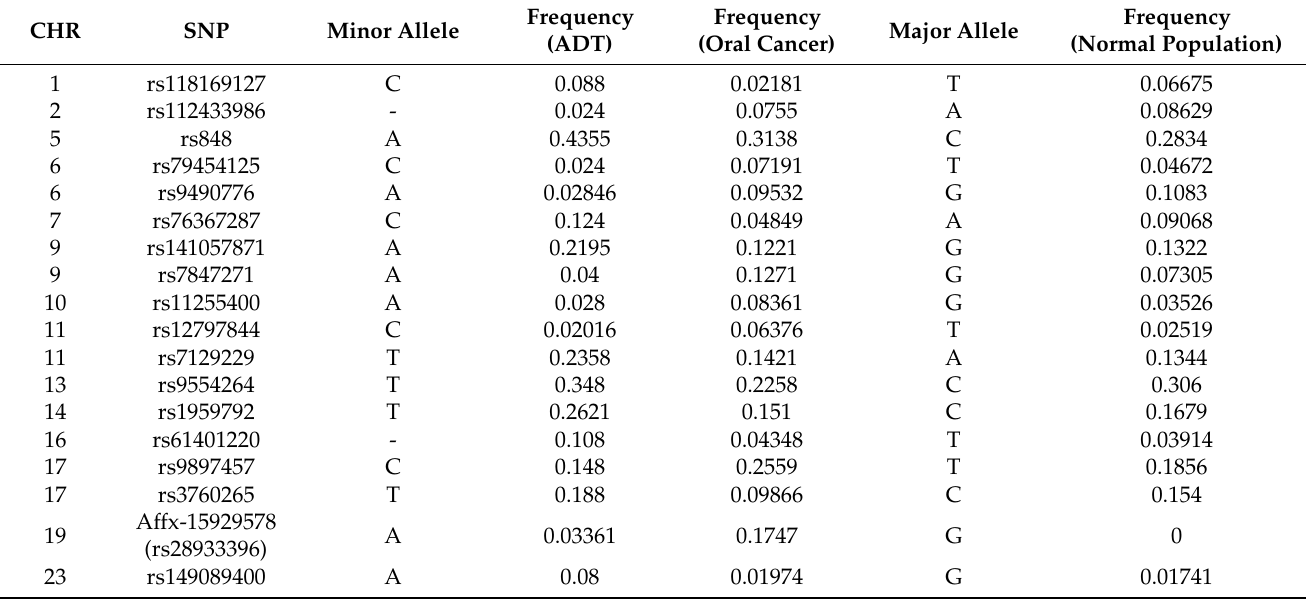
Table 2. The frequency of susceptible SNP locus in